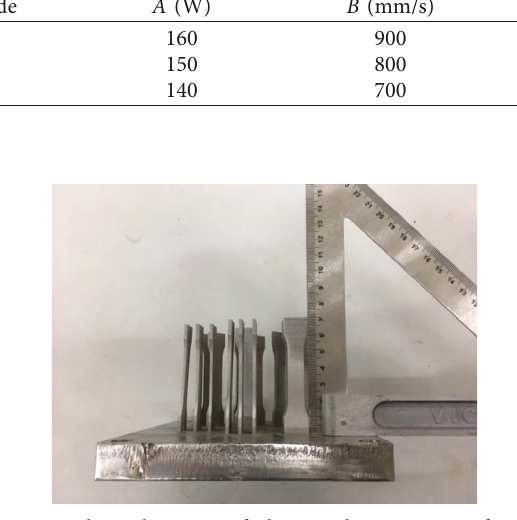
Figure 4: Physical image of the tensile specimen after heat treatment.